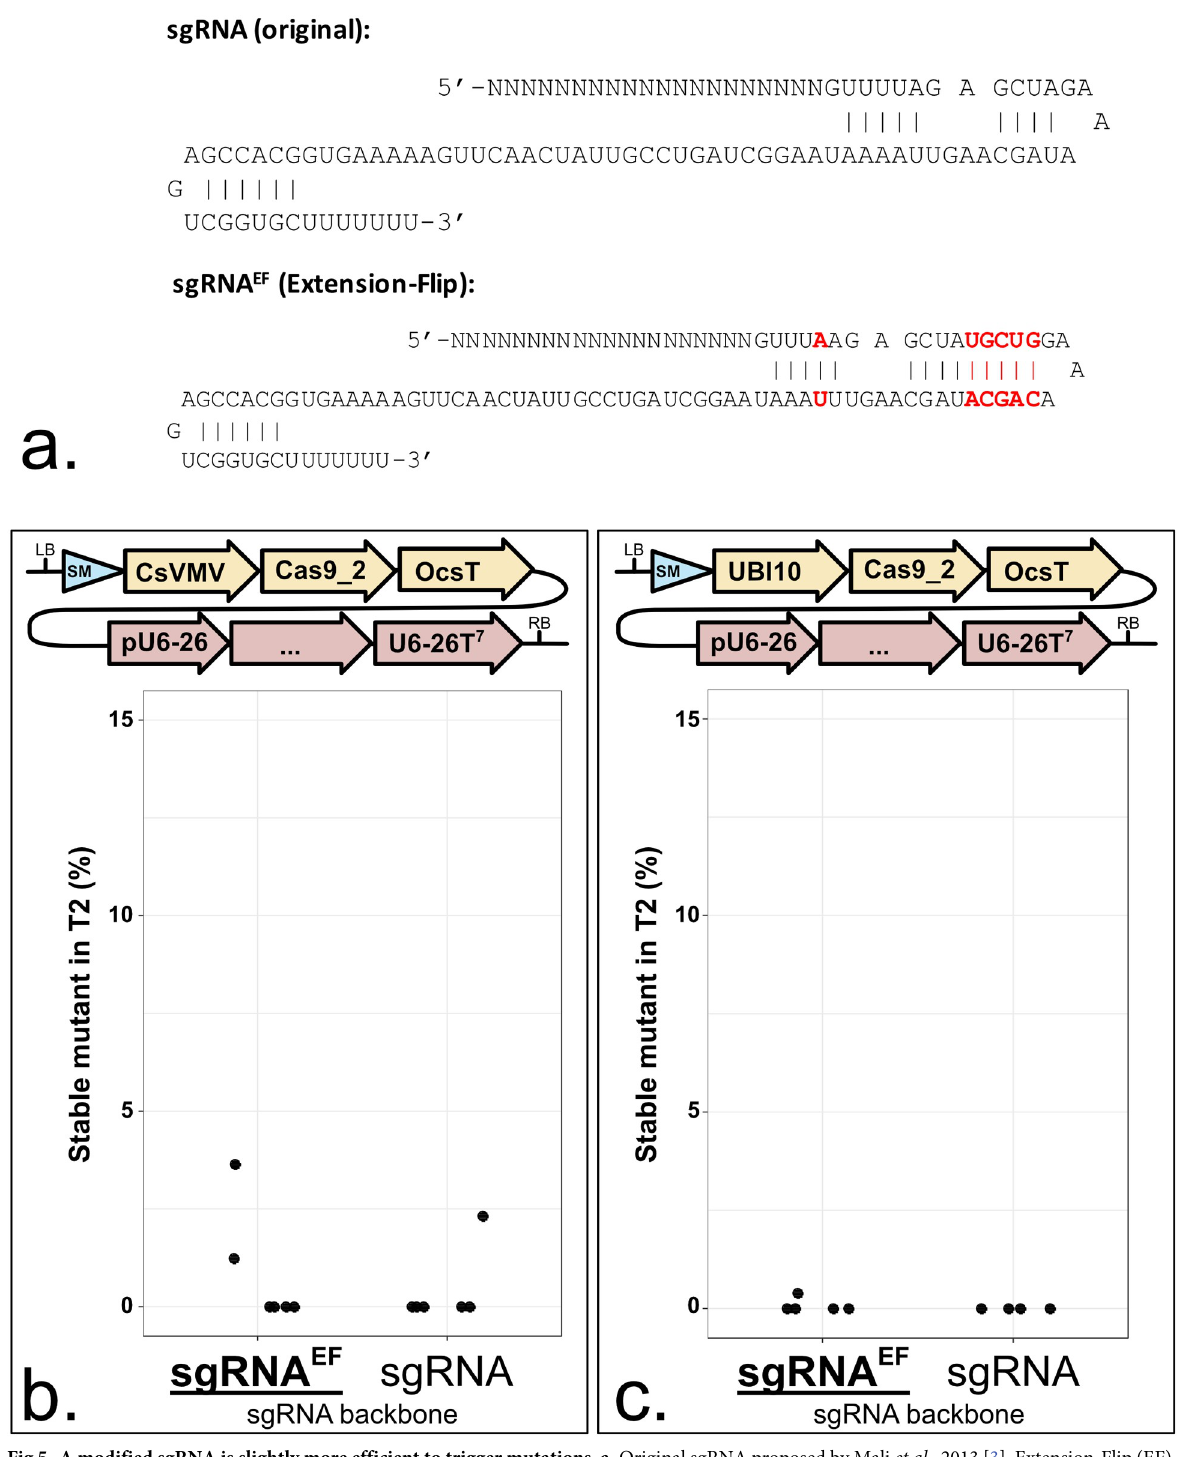
Fig 5. A modified sgRNA is slightly more efficient to trigger mutations. a. Original sgRNA proposed by Mali et al ., 2013 [3]. Extension-Flip (EF) sgRNA proposed by Chen et al ., 2013 [8]. b. and c. Each panel represents a sgRNA backbone comparison in the same context. sgRNA backbones can be compared within each panel but not from one panel to another. The modules were assembled into pICSL4723 (RB+OD, with an overdrive ) or pAGM4723 (RB, without an overdrive ) and transformed into Col-0 via Agrobacterium tumefaciens strain GV3101. LB: Left Border.